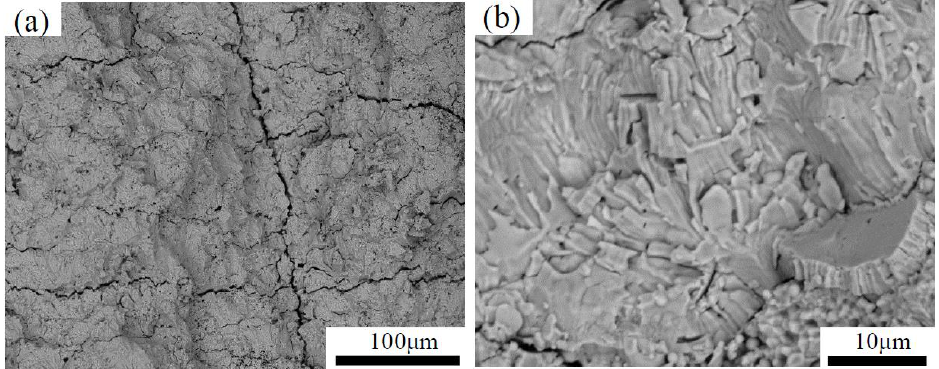
Figure 5. Fracture morphology of free-standing specimens: ( a ) at low (left) and ( b ) high (right) magnification).